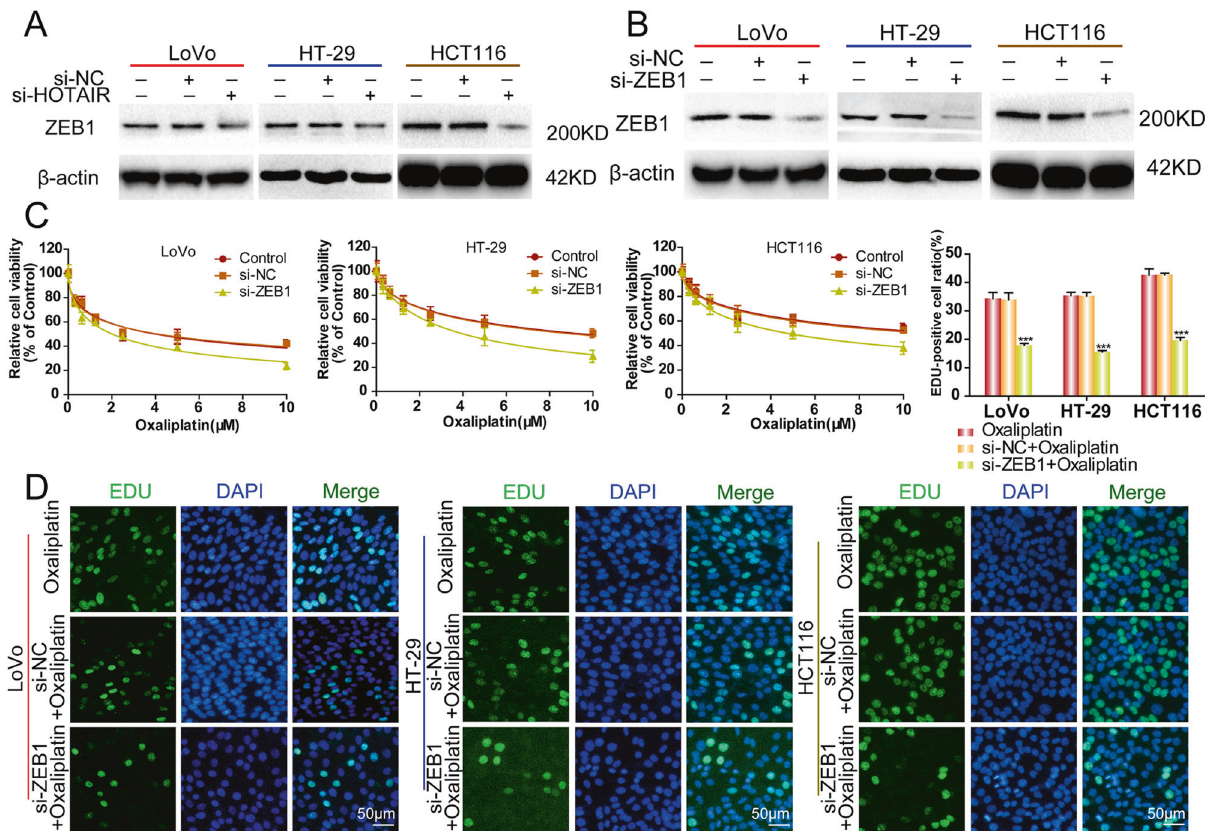
Fig. 4 HOTAIR ’ s effects on CRC cells are associated with ZEB1. A , B The western blotting assay was used to detect the ZEB1 expression after si-HOTAIR treatment or si-ZEB1 treatment. C CCK-8 was used to detect cell viability after si-ZEB1 treatment and exposure to oxaliplatin. D EdU was used to detect cell proliferation after si-ZEB1 treatment and exposure to oxaliplatin. *** p <